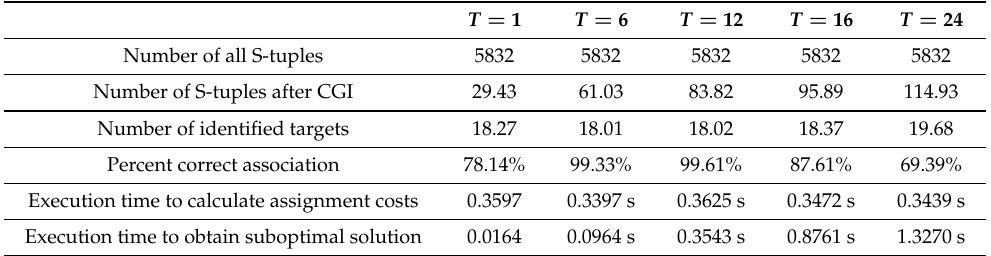
Table 4. The effect of different threshold T on the performance of CGI driven MDA.